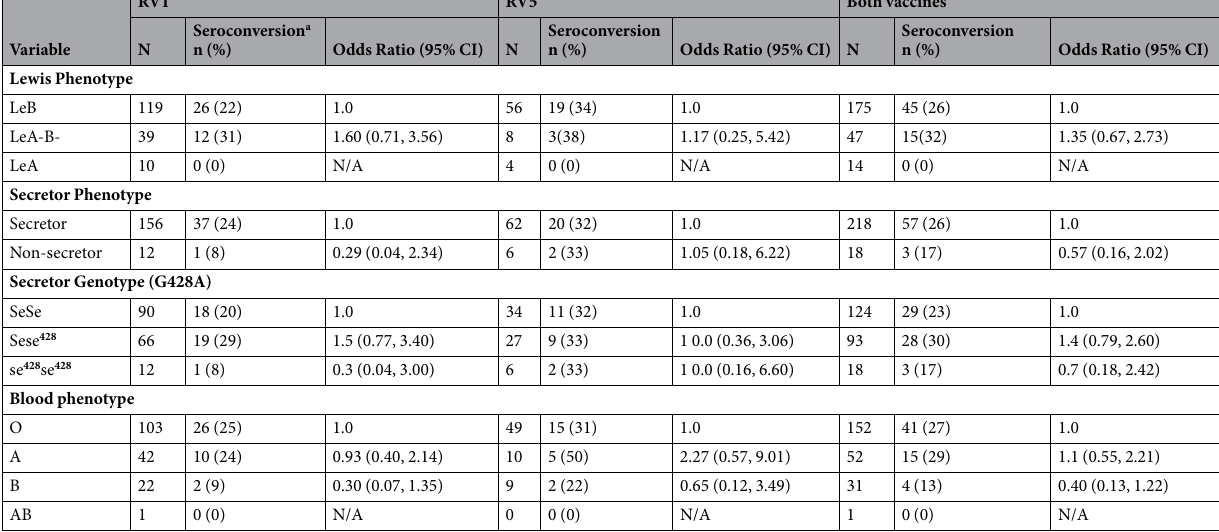
Table 1. HBGAs as predictors of rotavirus IgA seroconversion post RV1 or RV5 vaccination among Nicaraguan children. a Seroconversion was defined as a four-fold increase in rotavirus specific IgA titers 28 days post-vaccination. Abbreviations: RV1 = monovalent rotavirus vaccine; RV5 = pentavalent rotavirus vaccine; CI = confidence interval, N/A = not